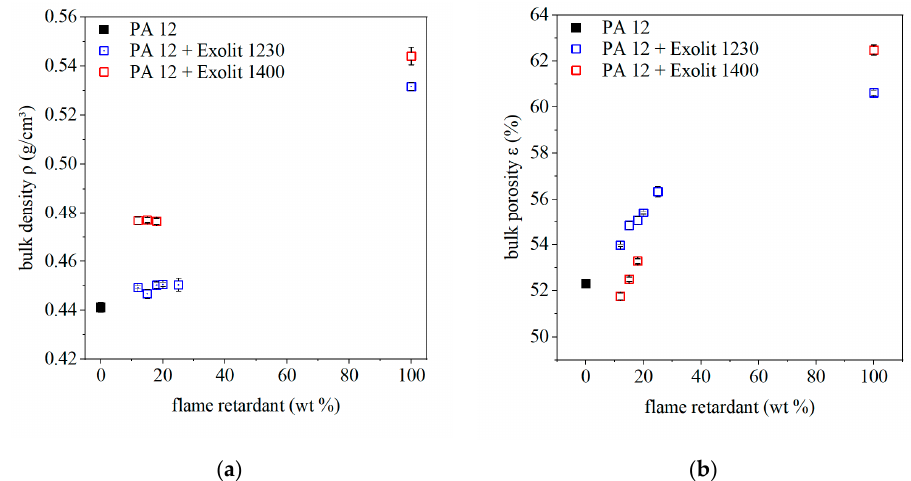
Figure 2. Bulk density ( a ); and bulk porosity ( b ) of the polymer and composite powders for different flame retardant concentrations. flame retardant